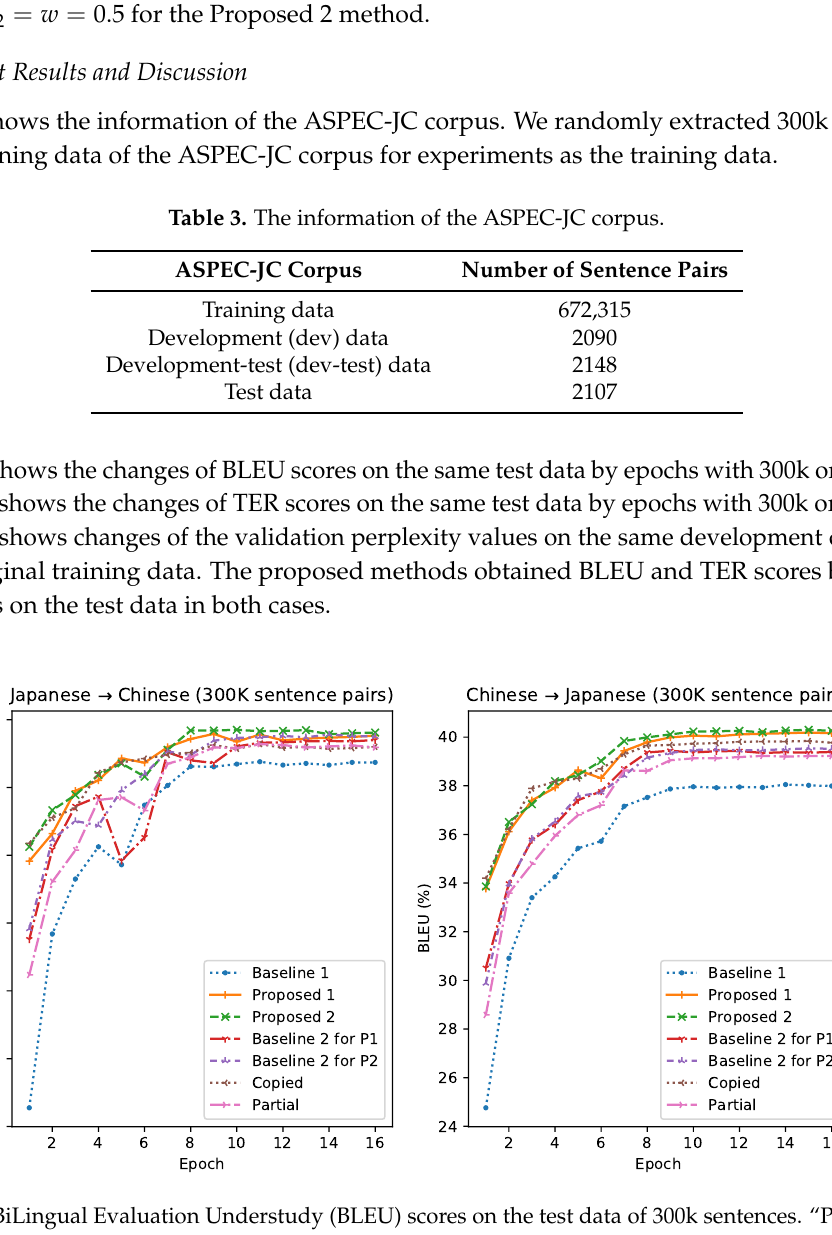
Figure 5. BiLingual Evaluation Understudy (BLEU) scores on the test data of 300k sentences. “P1” denotes the Proposed 1 method, “P2” denotes the Proposed 2